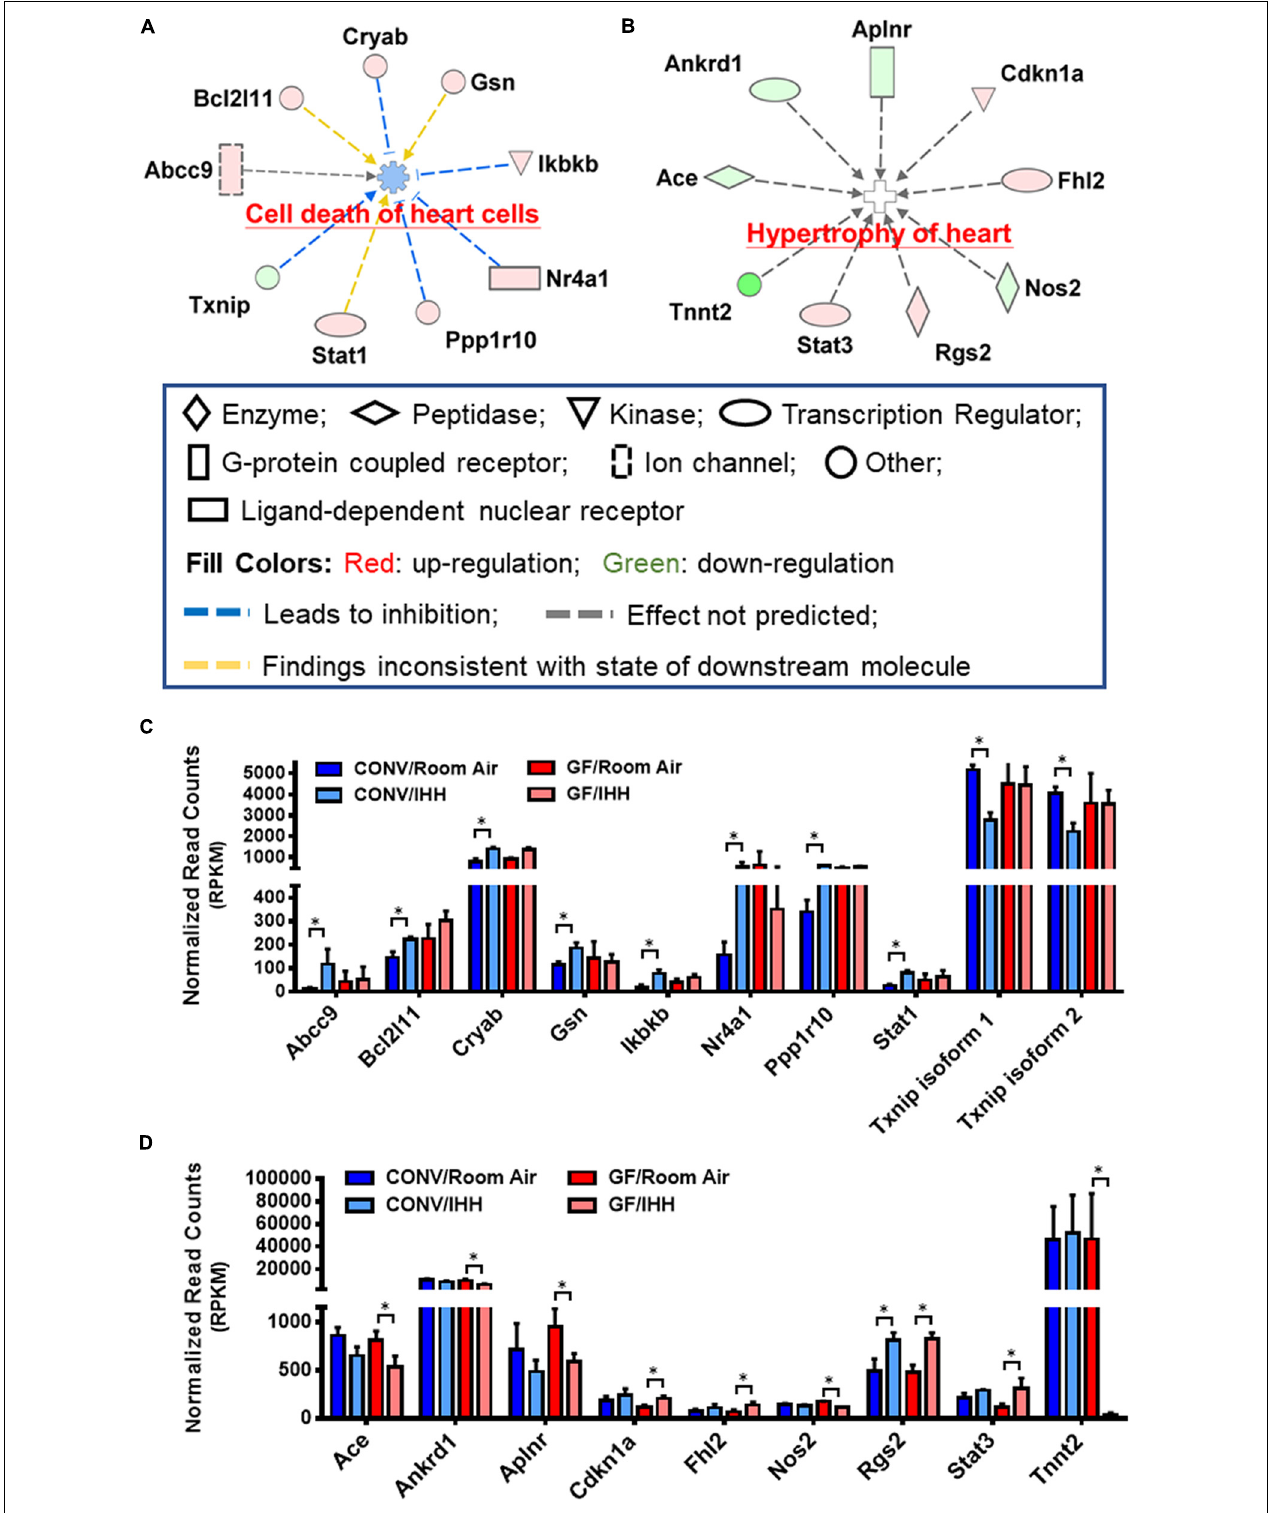
FIGURE 8 | Different set of cardiovascular diseases-related genes was altered in the heart of CONV and GF mice following IHH exposure. Prediction of clinical pathology endpoints driven by IHH-induced differentially expressed genes (DEGs) suggested a significant alteration of cardiac cell death in CONV (A) and cardiac hypertrophy in GF mice (B) under IHH condition (right-tailed Fisher’s exact test, p -value < 0.05). (C,D) Expressional abundance of the related DEGs in CONV and GF mice, respectively (* | Fold Change| > 1.5, Benjamini–Hochberg adjusted p < 0.05).